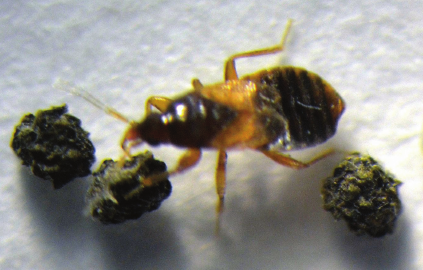
Figure 3: Adult of Xylocoris flavipes (Reuter, 1875) handling an egg of Cryptocephalus rufipes (Goeze,